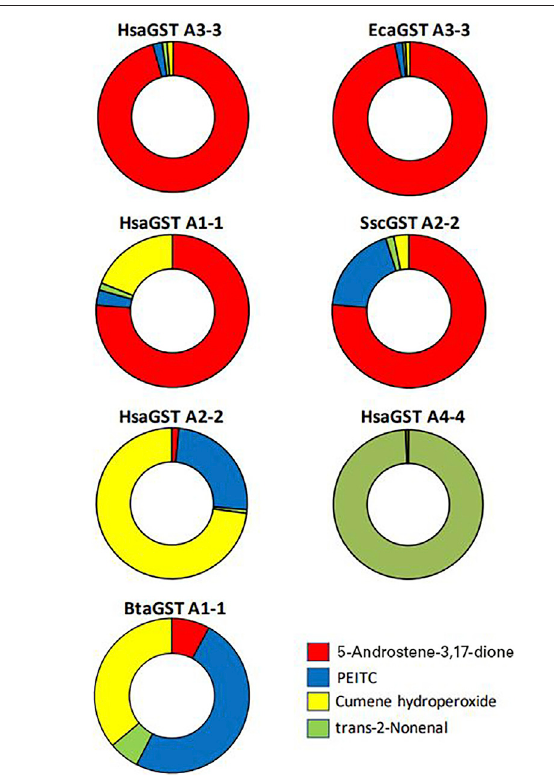
FIGURE 6 | Substrate selectivity pro fi les of some mammalian GSTs with fourphysiologicallyrelevantsubstratesincludingthesteroid5-androsten-3,17- dione. The doughnut pro fi les show the fractions of the total sum of catalytic activities with four alternative substrates representing physiologically relevantsubstrates.HsaGSTA3-3andEcaGSTA3-3demonstratestrongbias in favor of the isomerization of the steroid substrate, and HsaGST A1-1 and SscGST A2-2 also have an obvious preference for 5-AD. HsaGST A2-2 and BtaGST A1-1 are dominated by the activities with the hydroperoxide and the isothiocyanate PEITC, whereas HsaGST A4-4 is highly speci fi c for the alkenal.